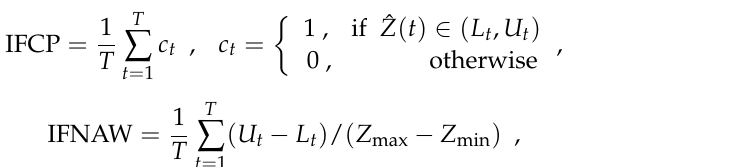
Figure 6. Prediction bias of PM2.5 concentration in Beijing. In the nine prediction models, the prediction bias of FOSSA– DeepAR is the smallest, which means FOSSA–DeepAR has best accuracy. Table 4 shows the evaluation indices of different models for point prediction of PM2.5 concentration. From Table 4, we see that the forecasting accuracy of the nine mod- els are different. TIC, RMSE, MAE, and MAPE of the FOSSA–DeepAR model are lower than other hybrid models and the single DeepAR model. At the same time, 𝑅 (cid:2870) of FOSSA– DeepAR is higher than other models. Accordingly, FOSSA–DeepAR outperforms other hybrid models and the single model for point prediction of PM2.5 concentration. Com- pared with a single DeepAR model, FOSSA–DeepAR model can reduce the RMSE of point prediction by an average of 5.76%, MAE by an average 10.39%, and MAPE by average 9.76%. In addition, compared with other hybrid models, FOSSA–DeepAR reduces the RMSE, MAE, and MAPE by an average of 2.834%, 6.243%, and 22.55%, respectively. In addition, the 𝑅 (cid:2870) of FOSSA–DeepAR is 0.93 and is higher than other benchmark models.